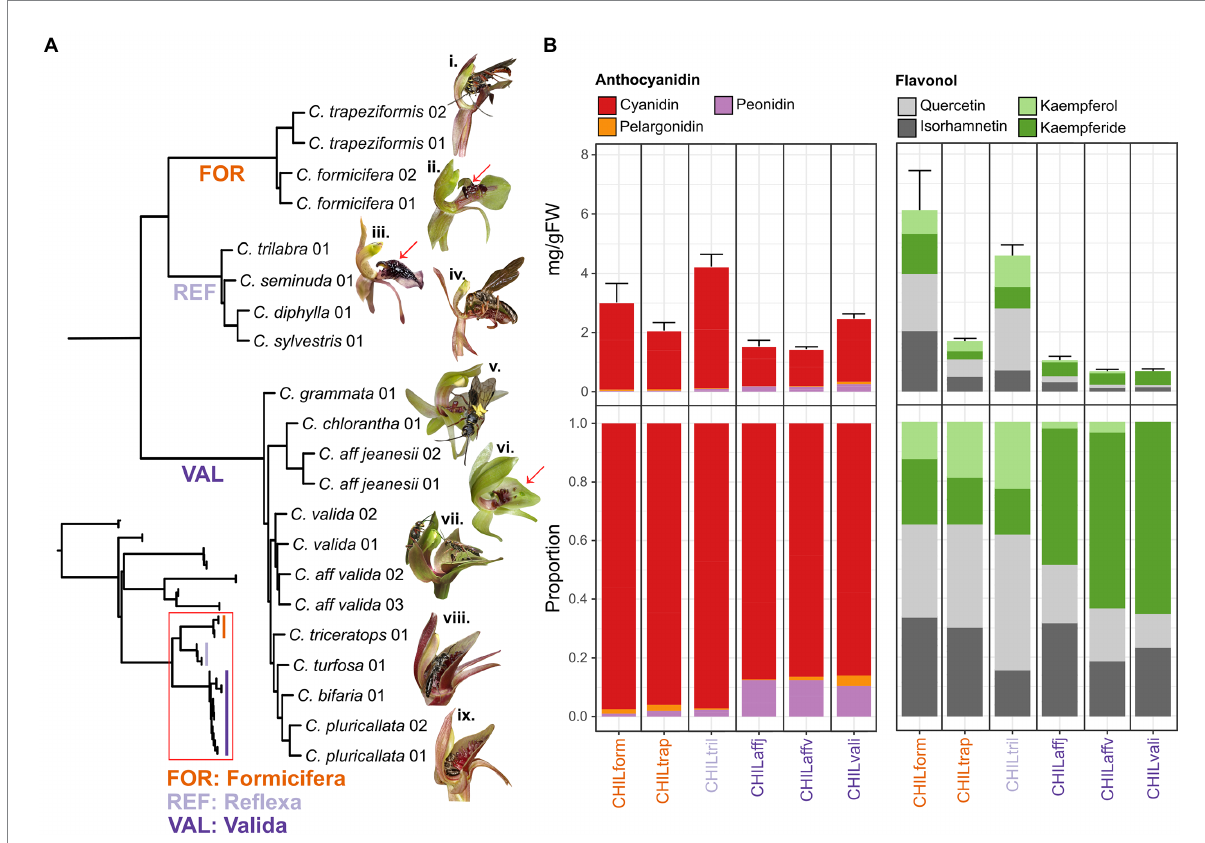
FIGURE 1 Phylogenetic patterns of anthocyanin and flavonol glycosides in a cross-section of Chiloglottis orchids. (A) The full (inset, top left) and close up (red boxed) ASTRAL species tree phylogeny of Chiloglottis (red boxed) with and without representatives from Arthrochilus , Caleana , Drakaea , Paracaleana , and Spiculaea genera as outgroup is illustrated, respectively. Representative flowers from the FOR ( i. C. trapeziformis , ii. C. formicifera ), REF ( iii. C. trilabra , iv. C. diphylla ), and VAL ( v. C. chlorantha , vi. C. aff. jeanesii , vii. C. aff. valida , viii. C. turfosa , ix. C. bifaria ) clades are shown. Red arrows point to the dark, three-dimensional insectiform calli/callus structure on the labellum lamina of representative FOR, REF, and VAL clades. Floral traits in each clade typically range as follows—FOR: flowers 6–8 mm wide × 12–16 mm long; labellum 6–7 mm wide × 8–10 mm long; length to width ratio 1.3–1.4 ×, REF: flowers 4–9 mm wide × 10–34 mm long; labellum 5–8 mm wide × 9–11 mm long; length to width ratio 1.5–1.9 ×, and VAL: flowers 15–30 mm wide × 18–30 mm long; labellum 9–14 mm wide × 10–17 mm long; length to width ratio close to 1. (B) Bar graphs showing total anthocyanins and flavonol glycoside co-pigment content grouped by aglycone (average ± s.e.) and their corresponding proportion in the calli/callus of naturally opened flowers. See Supplementary Figure S3 for full ASTRAL species tree phylogeny and Supplementary Figures S4, S5 for detailed flowering time, flower size, and labellum size